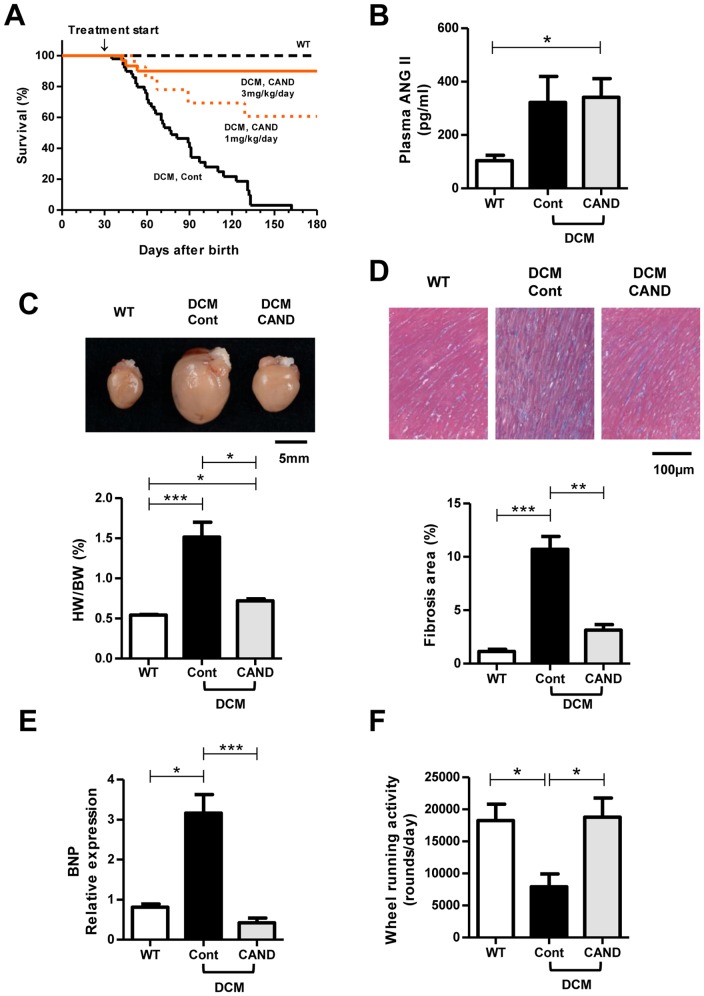
Effects of candesartan on survival rate, and cardiac histology and functions.
A. Survival curves of control DCM (Cont) (n = 49), candesartan-treated DCM (CAND) (1 mg/kg/day: n = 14, 3 mg/kg/day: n = 30) and non-treated WT mice (n = 34). B. Plasma Ang II level (WT: n = 6, Cont: n = 5, CAND: n = 6). C. Typical gross morphology of hearts (upper image) and average HW/BW ratio (lower panel) (WT: n = 11, Cont: n = 11, CAND: n = 12). D. Histology of the LV myocardium. Connective tissues were stained blue with Azan. Upper images: typical images. Lower panel: quantitative analysis of the fibrotic area in the myocardium (three hearts in each group). E. Gene expression level of BNP in the LV (WT: n = 10, Cont: n = 15, CAND: n = 12). F. Wheel running activity (WT:n = 11, Cont: n = 10, CAND: n = 10). Data are the mean ± SEM. *P<0.05, **P<0.01, ***P<0.001.